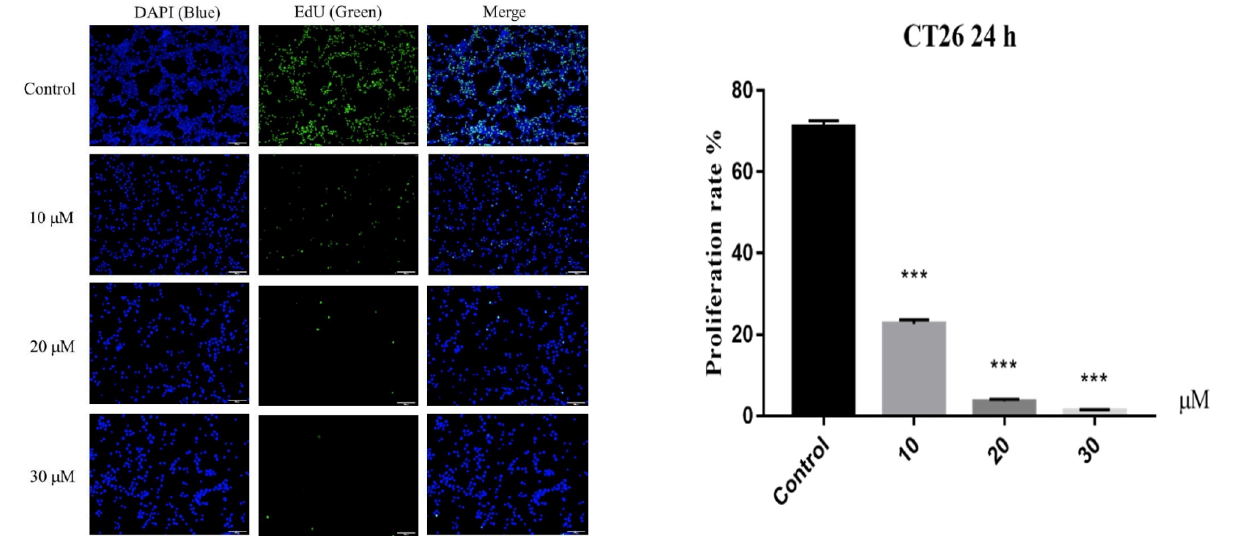
Figure 5. Cell proliferation assay of CT26 cell line at different concentrations of compound 5 (10, 20, and 30 µ M) after 24 h. Data are present as the mean ± SD, compared with the control group. *** p < 0.001 ( n = 3).